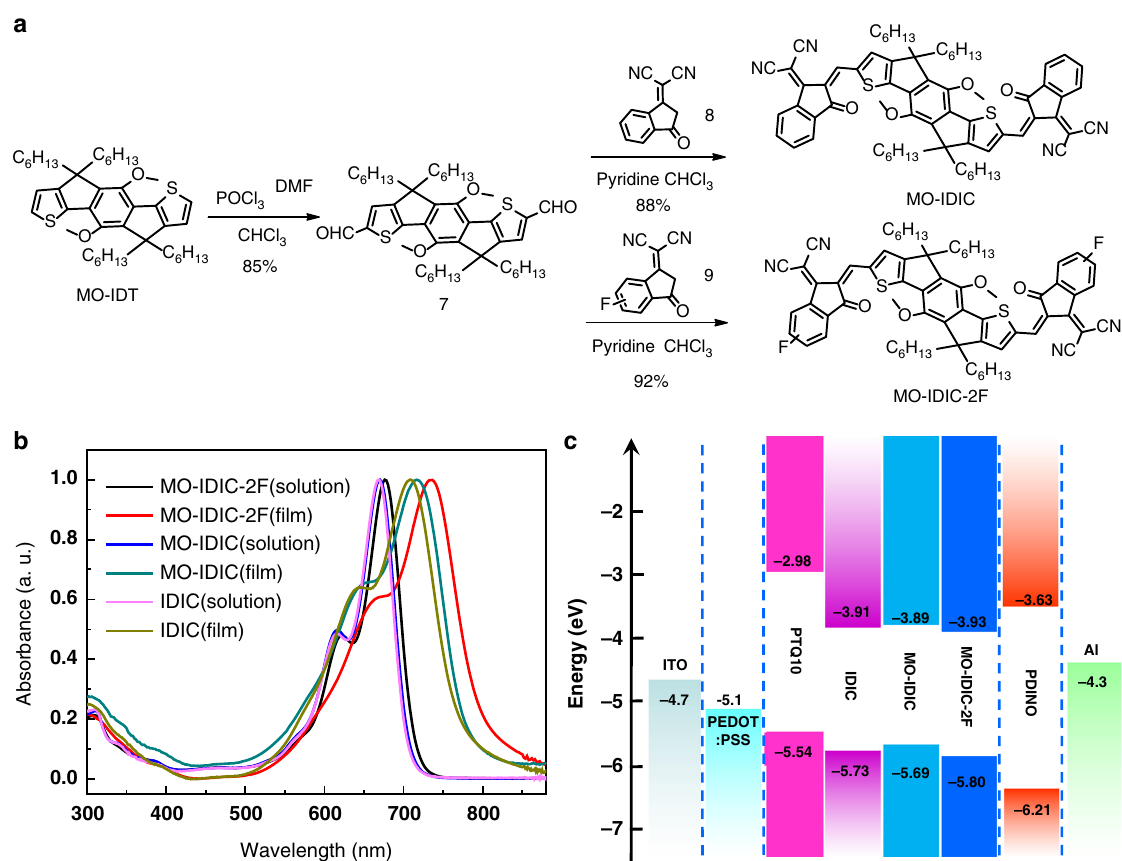
Fig. 2 Synthetic routes and physicochemical properties of the acceptors. a Synthetic routes of MO-IDIC and MO-IDIC-2F, b absorption spectra of IDIC, MO-IDIC, and MO-IDIC-2F in chloroform solutions and fi lms, c energy level diagram of the related materials used in the PSCs (the energy levels were measured by electrochemical cyclic